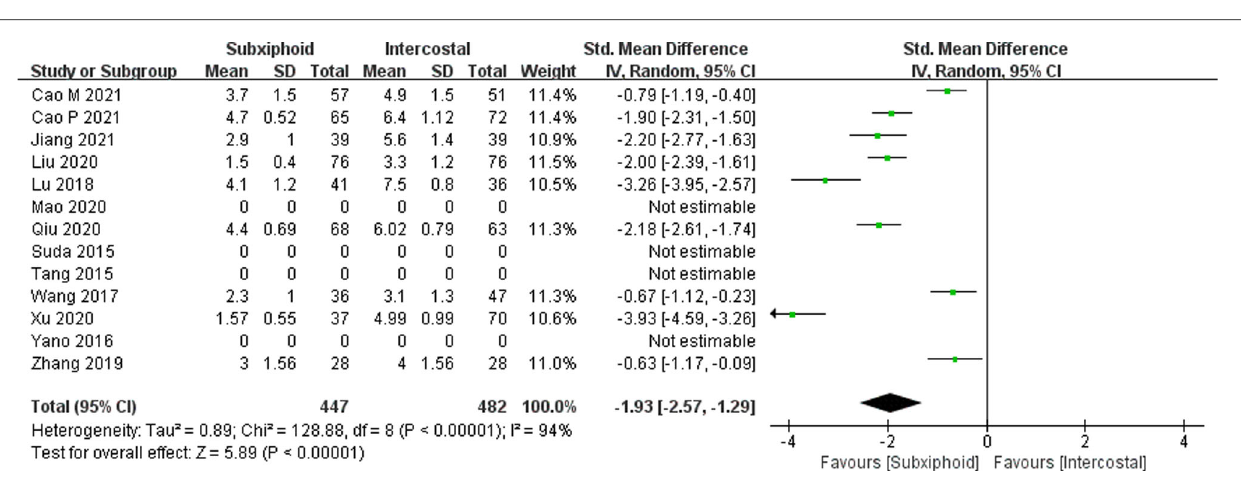
FIGURE 9 | Forest plot of the role of SMD and its 95% CI of VAS score on the day of operation between SVATS and IVATS